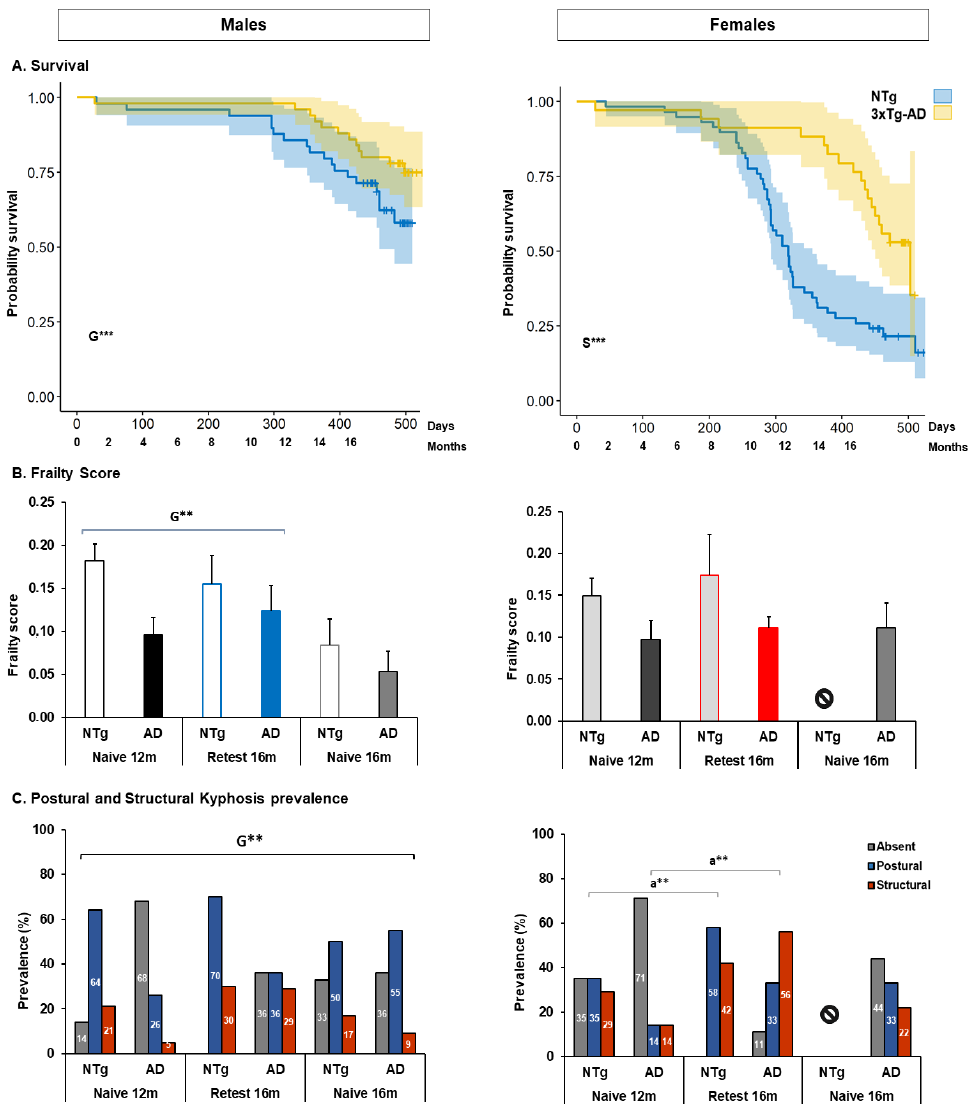
Figure 2. Survival, frailty score, and postural and structural kyphosis. ( A ) Survival. Statistics: Kaplan–Meier test—Log rank, G, genotype effect: χ 2 , G*** p < 0.001***; S, sex effect: χ 2 , S*** p < 0.001***. ( B ) Frailty score. Statistics: ANOVA, G, genotype effect: G** p < 0.01**. ( C ) Postural and structural kyphosis. Statistics: Fisher’s exact test, G, genotype effect in males, G** p < 0.01**; a, aging effect in females: a** p < 0.01**. The symbol ⦸ indicates the absence of the group, and m, months.